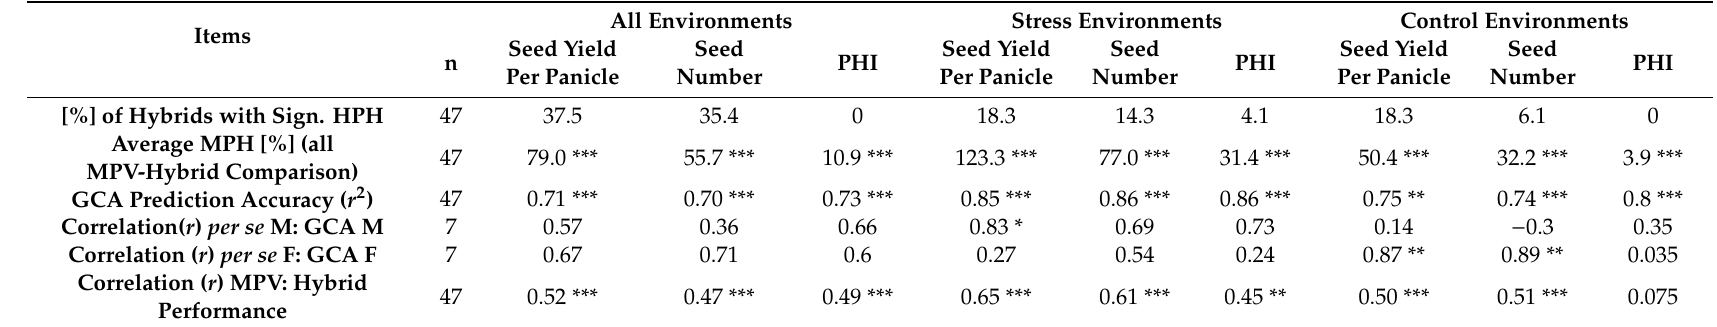
Table 6. Heterosis, GCA prediction accuracy and Pearson´s correlation ( r ) between line per se and hybrid performance for the field trials (stress environments: Asendorf 2017, Poel 2017 and Texcoco 2017; control environments: Gross-Gerau 2018, Poel 2018, San Juan del R í o